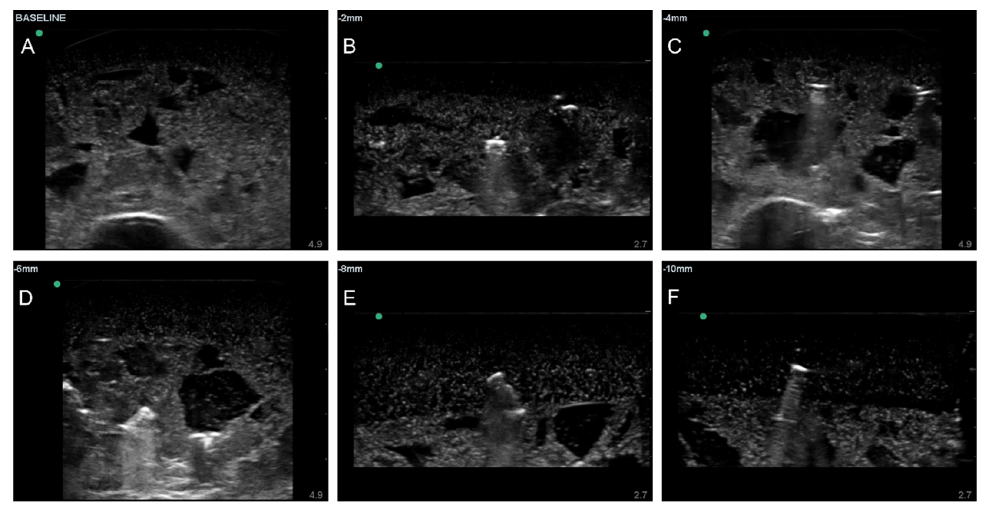
Figure 1. Representative ultrasound images for preprocessed baseline ( A ) and shrapnel of varying sizes—2 mm ( B ), 4 mm ( C ), 6 mm ( D ), 8 mm ( E ), and 10 mm ( F )—acquired in the gelatin phantom.